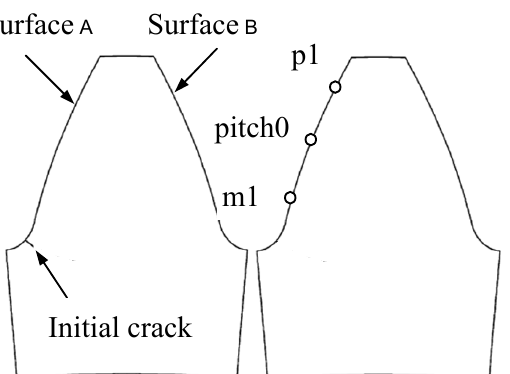
Figure 9. Scheme of a gear tooth.